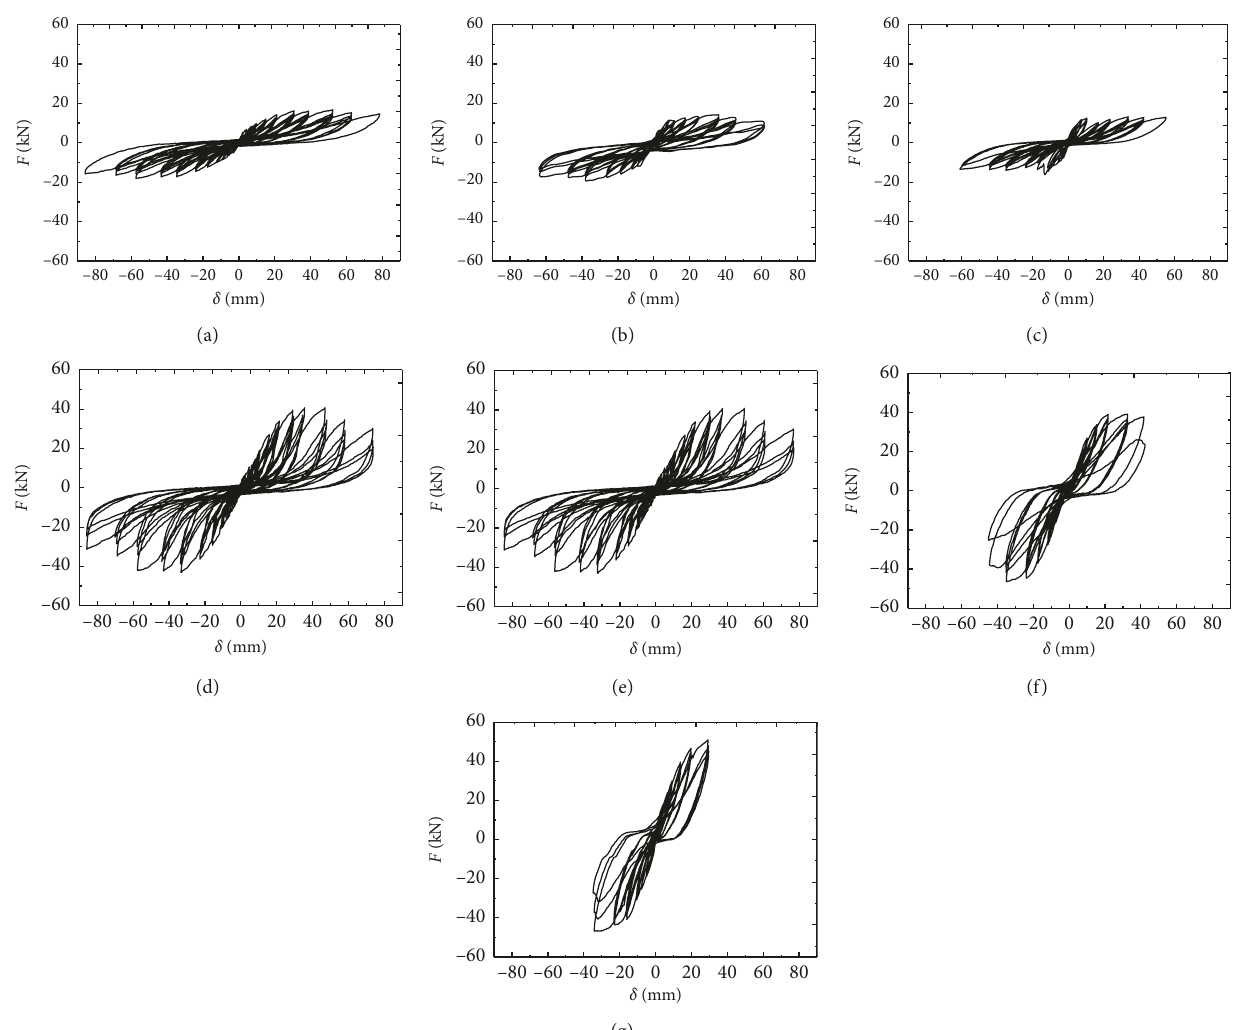
Figure 13: Hysteretic curves. (a) Specimen KJ1. (b) Specimen KJ2. (c) Specimen KJ3. (d) Specimen ZHQ1. (e) Specimen ZHQ2. (f) Specimen ZHQ3. (g) Specimen 3.3.SkeletonCurve. The skeleton curve is the envelope curve formed by connecting the peak points of the first cycle of each loading stage of the hysteretic curve. The skeleton curves of the specimens are shown in Figure 14.